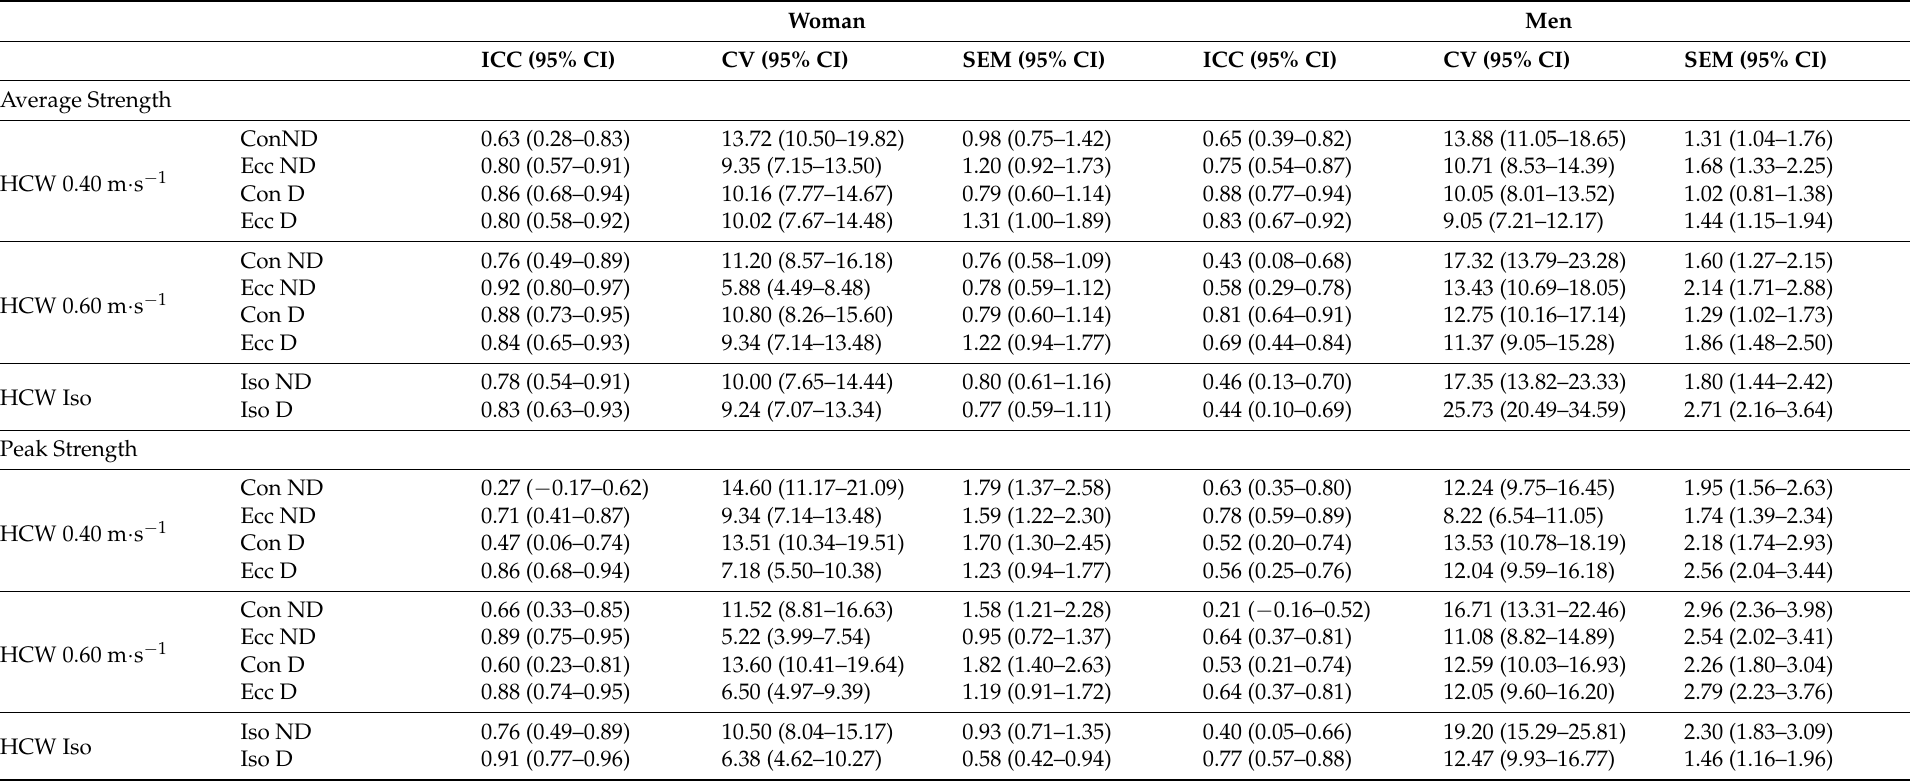
Table 4. Women and men reliability of average and peak strength horizontal cable woodchop